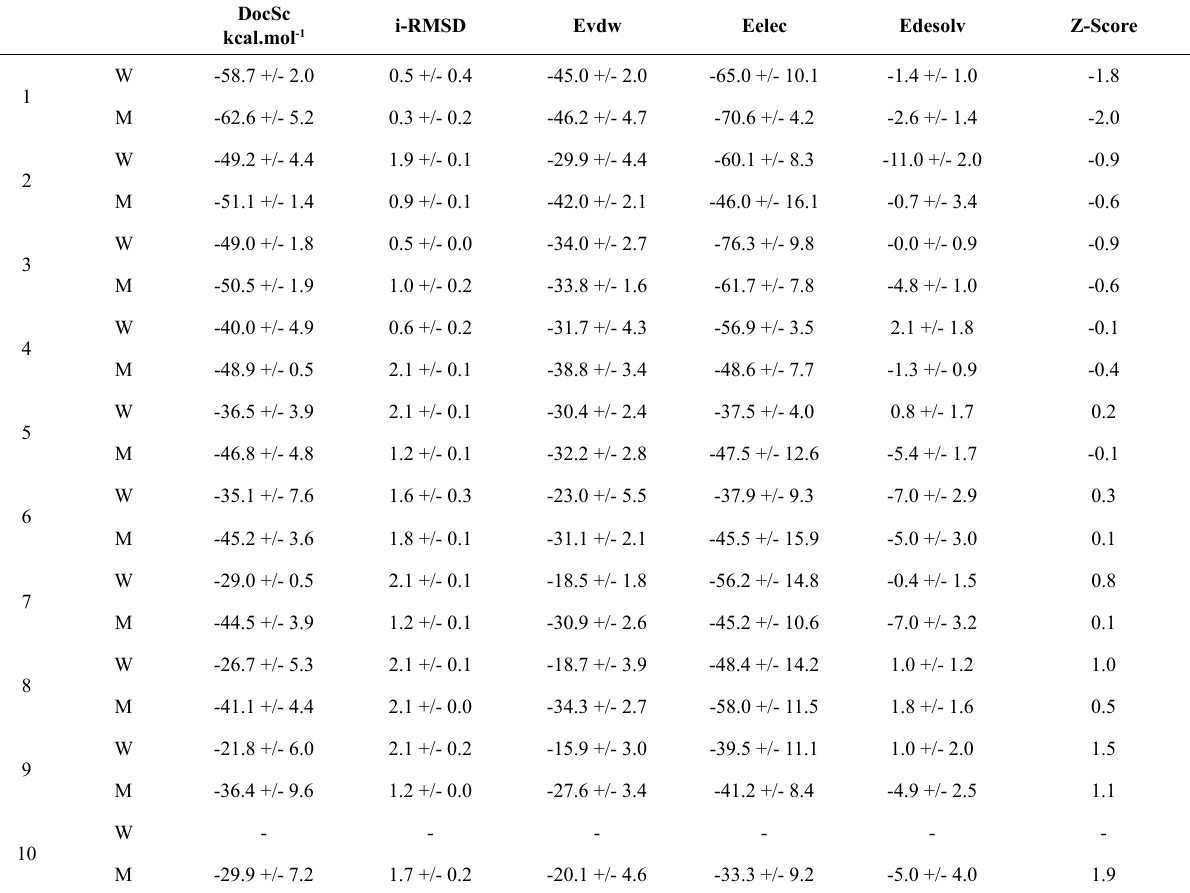
Table 3 - Docking results of wild and mutant 3CL pro of SARS-CoV-2 with the